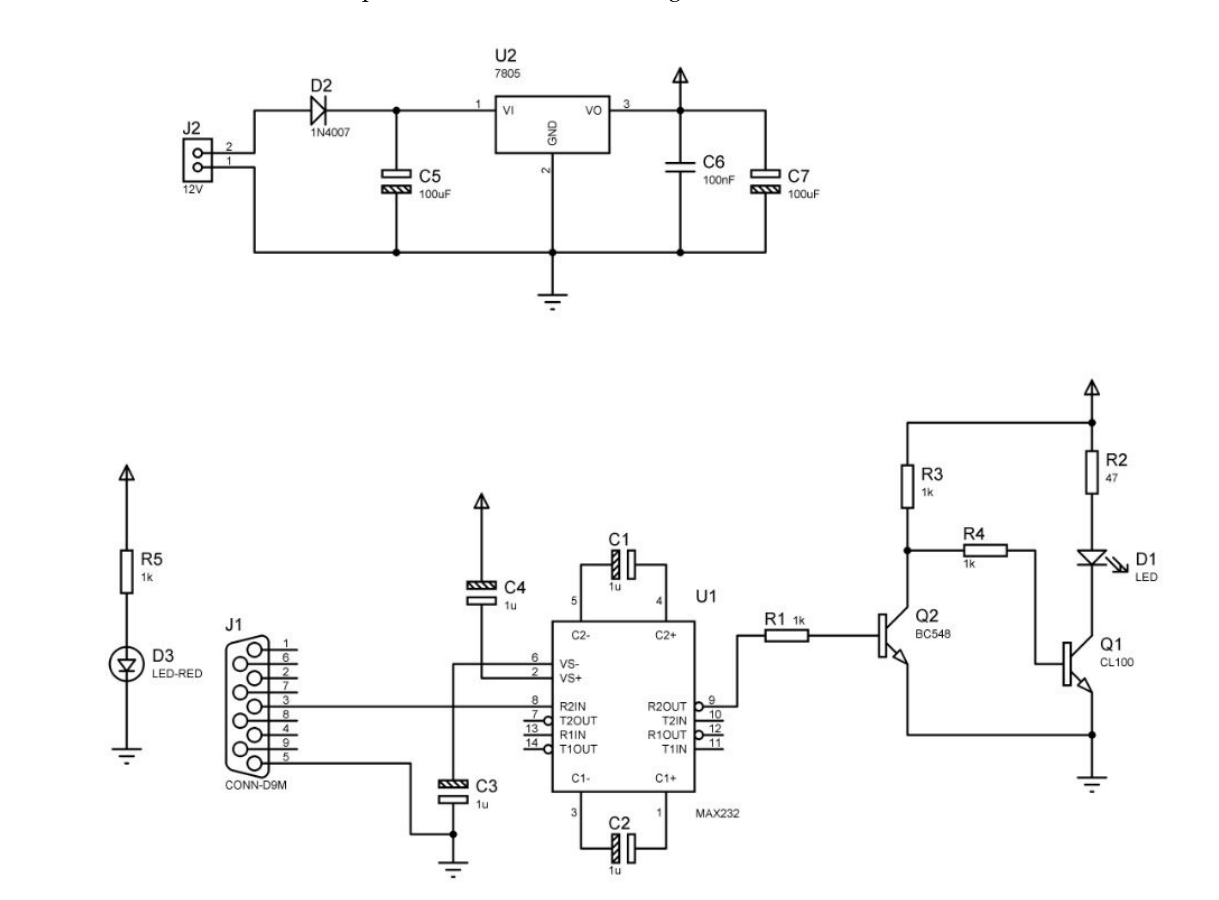
Figure 8. VLC transmitter design for hardware